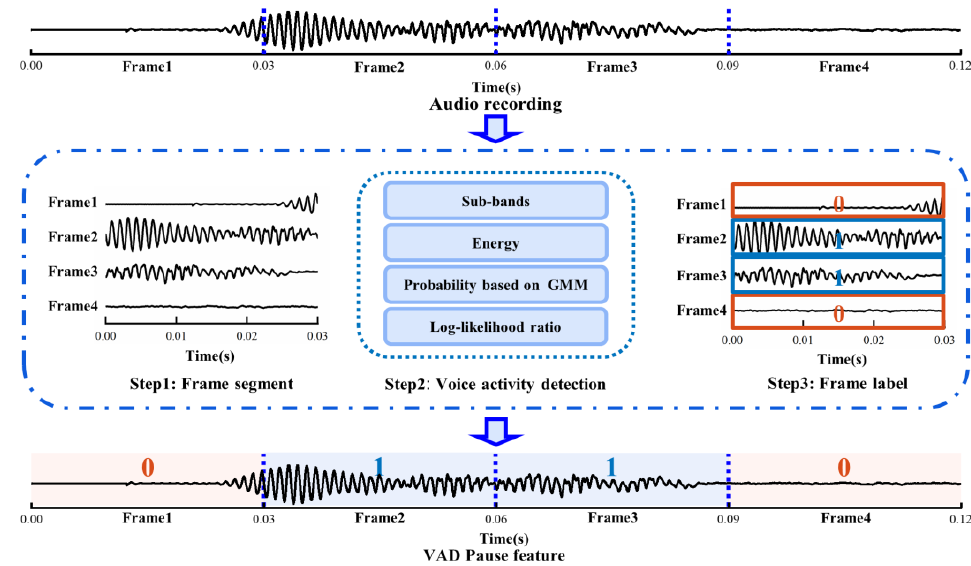
Figure 2. Schematic diagram of extracting VAD Pause. GMM, Gaussian mixture model.